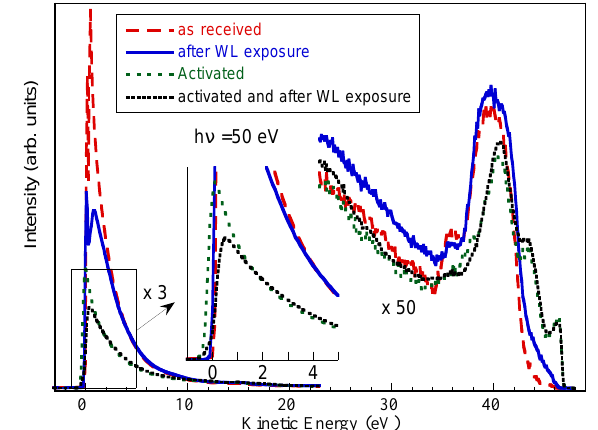
FIG. 7. (Color) The photoemission spectra, taken at 50 eV photon energy, of TiZr as received, after WL exposure, after annealing in UHV (pressure during annealing was less than 10 2 8 mbar) at (cid:2) 330 6 30 (cid:3) ± C for 4 h (TiZr-ac.), and after WL exposure of the annealed